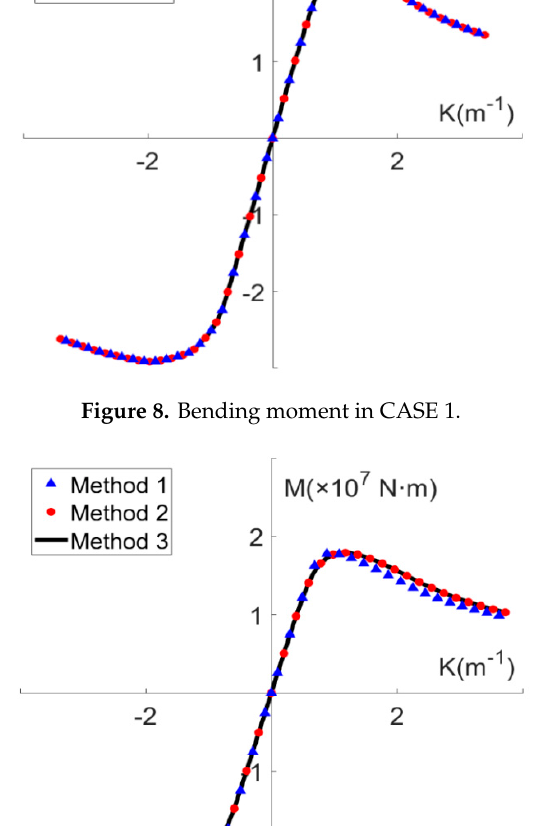
Figure 10. Bending moment in CASE 3. Figure 11. Height of neutral axis in CASE 1.